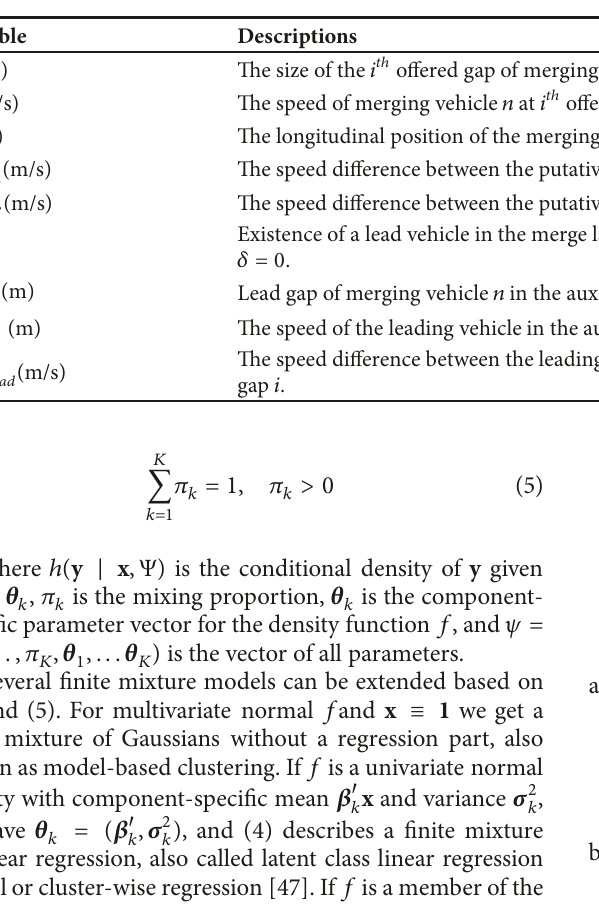
Table 3: Descriptions of the explanatory